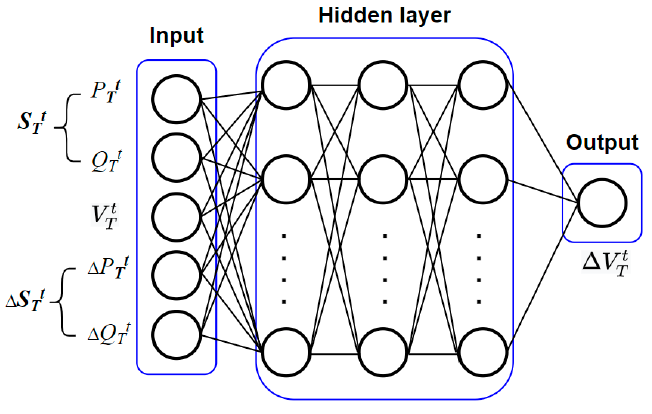
Figure 7. Low-Voltage Machine Learning Model. Table 2. Number of neurons for each layer in the structure of LV-ML.